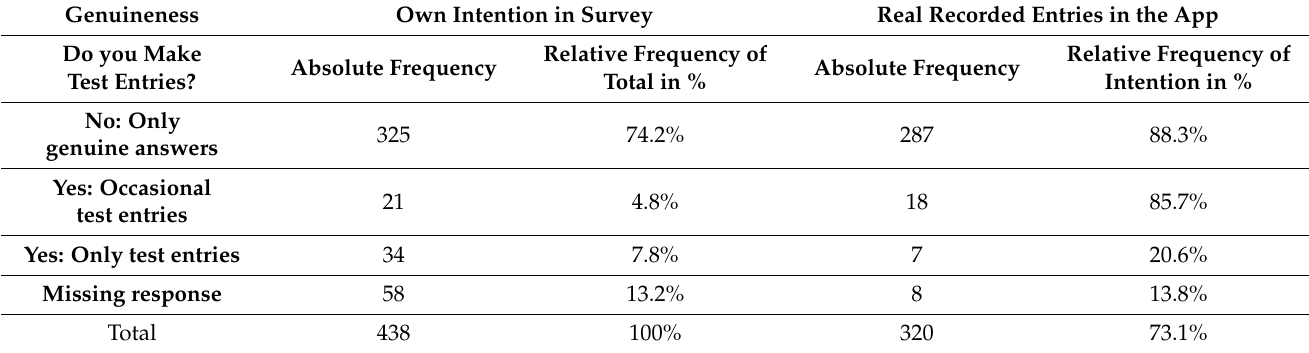
Table 4. Reported genuineness of